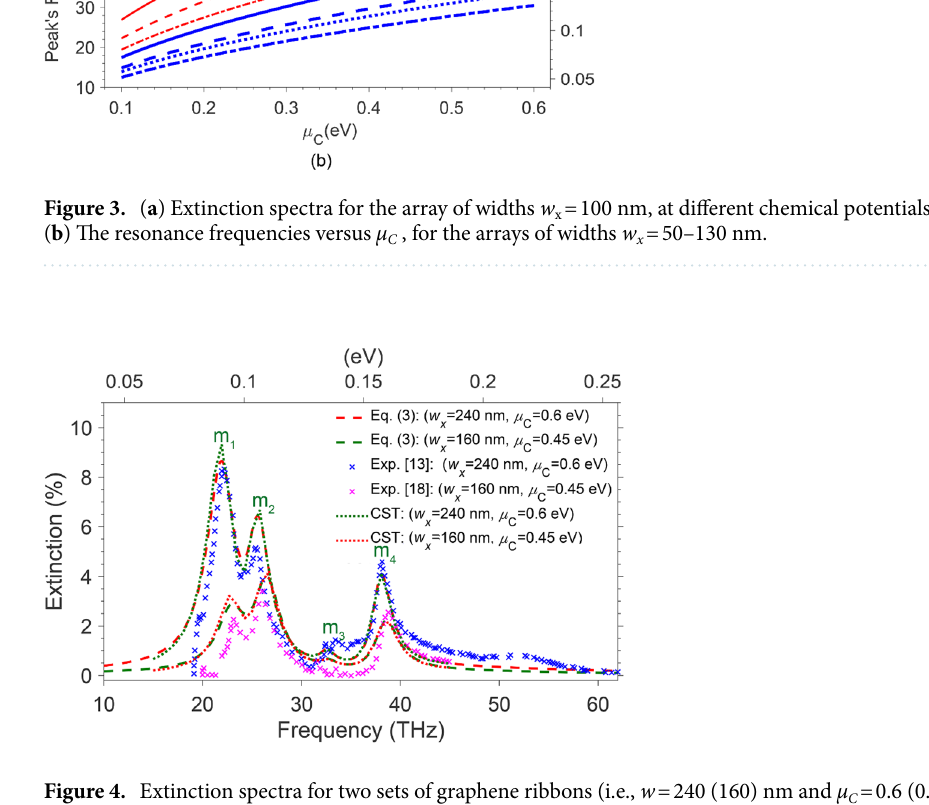
Figure 4. Extinction spectra for two sets of graphene ribbons (i.e., w = 240 (160) nm and μ C = 0.6 (0.45) eV) placed on SiO 2 with surface optical phonons of energies ħω 1, 2, 3 = 100, 134, and 144.8 meV. The red (green) dashes show the corresponding results obtained from (3), the blue (magenta) crosses represent the experimental results reported by 13,18 , and the green (red) dots show the CST outcome, using (6). The labels m 1 − m 4 denote the peaks of the four coupled phonons-plasmons